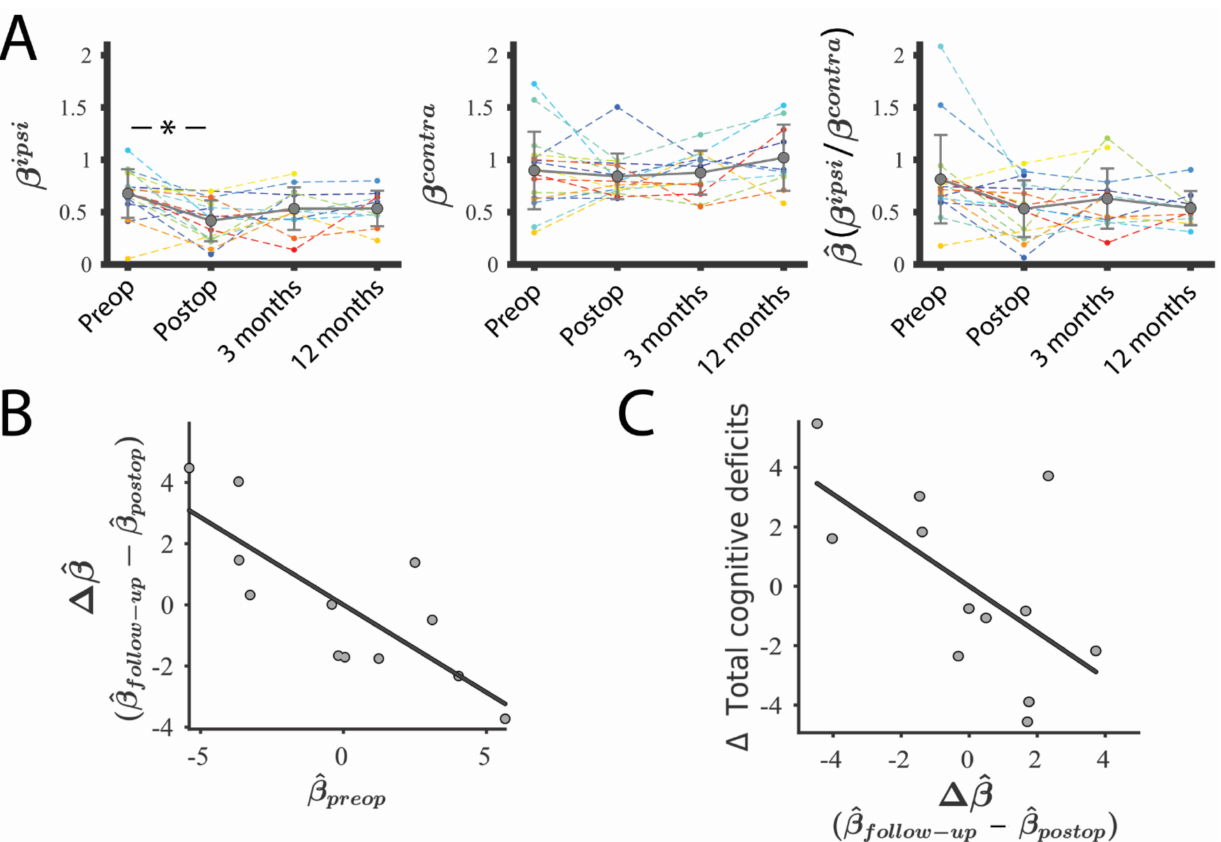
Figure 5. Coupling between GS and lesioned tissue during patients’ recovery. ( A ). Coupling between the GS and tumour (pre-operative) and lesion (post-operative and follow-up) BOLD signal ( β ipsi ; left). Coupling between GS and the healthy regions contralateral to the tumour/lesion ( β contra ; middle). The normalised coupling was defined as the ratio between both metrics (ˆ β ; right). Preop, Pre-operative assessment; Postop, post-operative assessment. * represents p < 0.05 ( B ). Association between normalised pre-operative tumour–GS coupling (ˆ β preop ) and the rate of change of the lesion–GS coupling during recovery ( ∆ ˆ β , defined as ˆ β follow − up − ˆ β postop ). ( C ). Cognitive recovery (positive represents acquired deficits during recovery) as a function of the rate of change of lesion–GS coupling during recovery. Associations were calculated after regressing out the effects of age, tumour volume and type of treatment. ˆ β follow − up corresponds with the β value of the last MRI scan available for each patient (i.e., 3 or 12 months, depending on missing